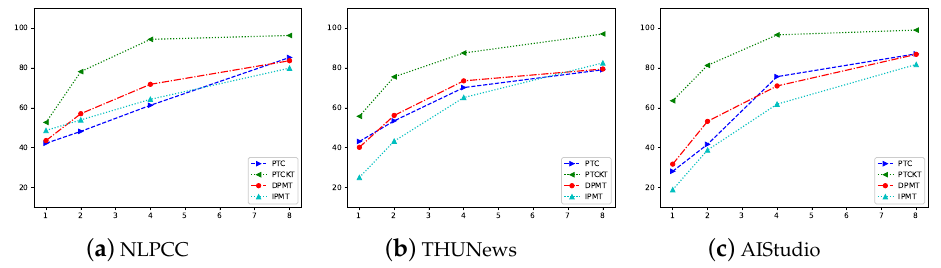
Figure 5. F1 score with different values of K for the few-shot